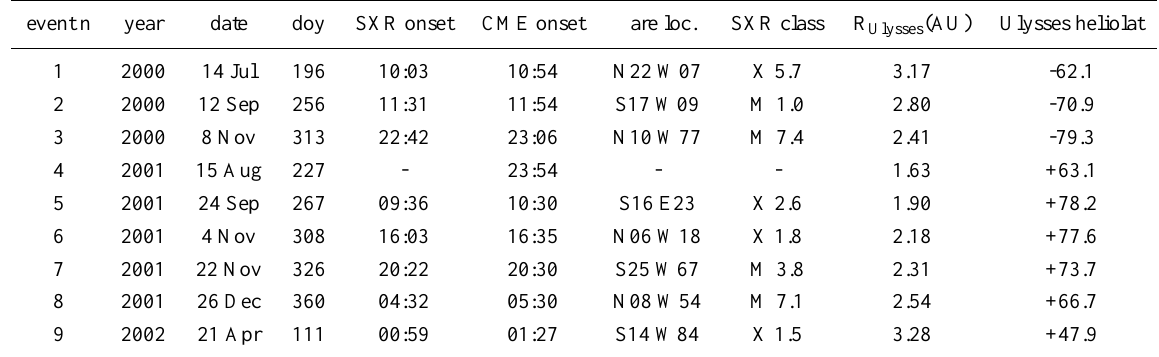
Table 1. SEP events at high latitudes